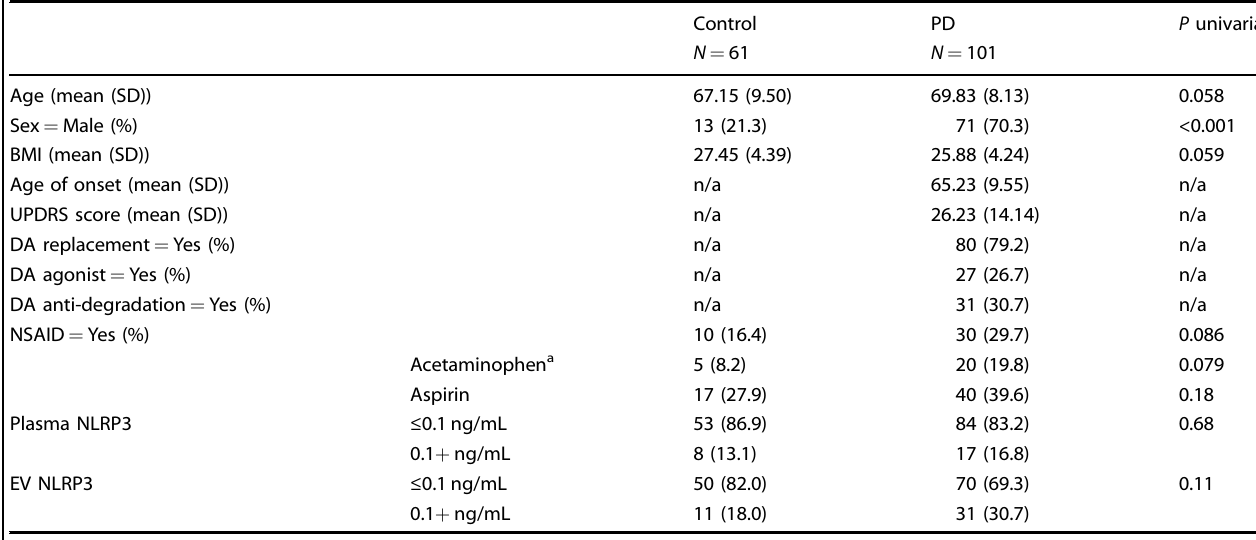
Table 4. NLRP3 is higher in the EV fraction than crude plasma in the DHMC cohort.